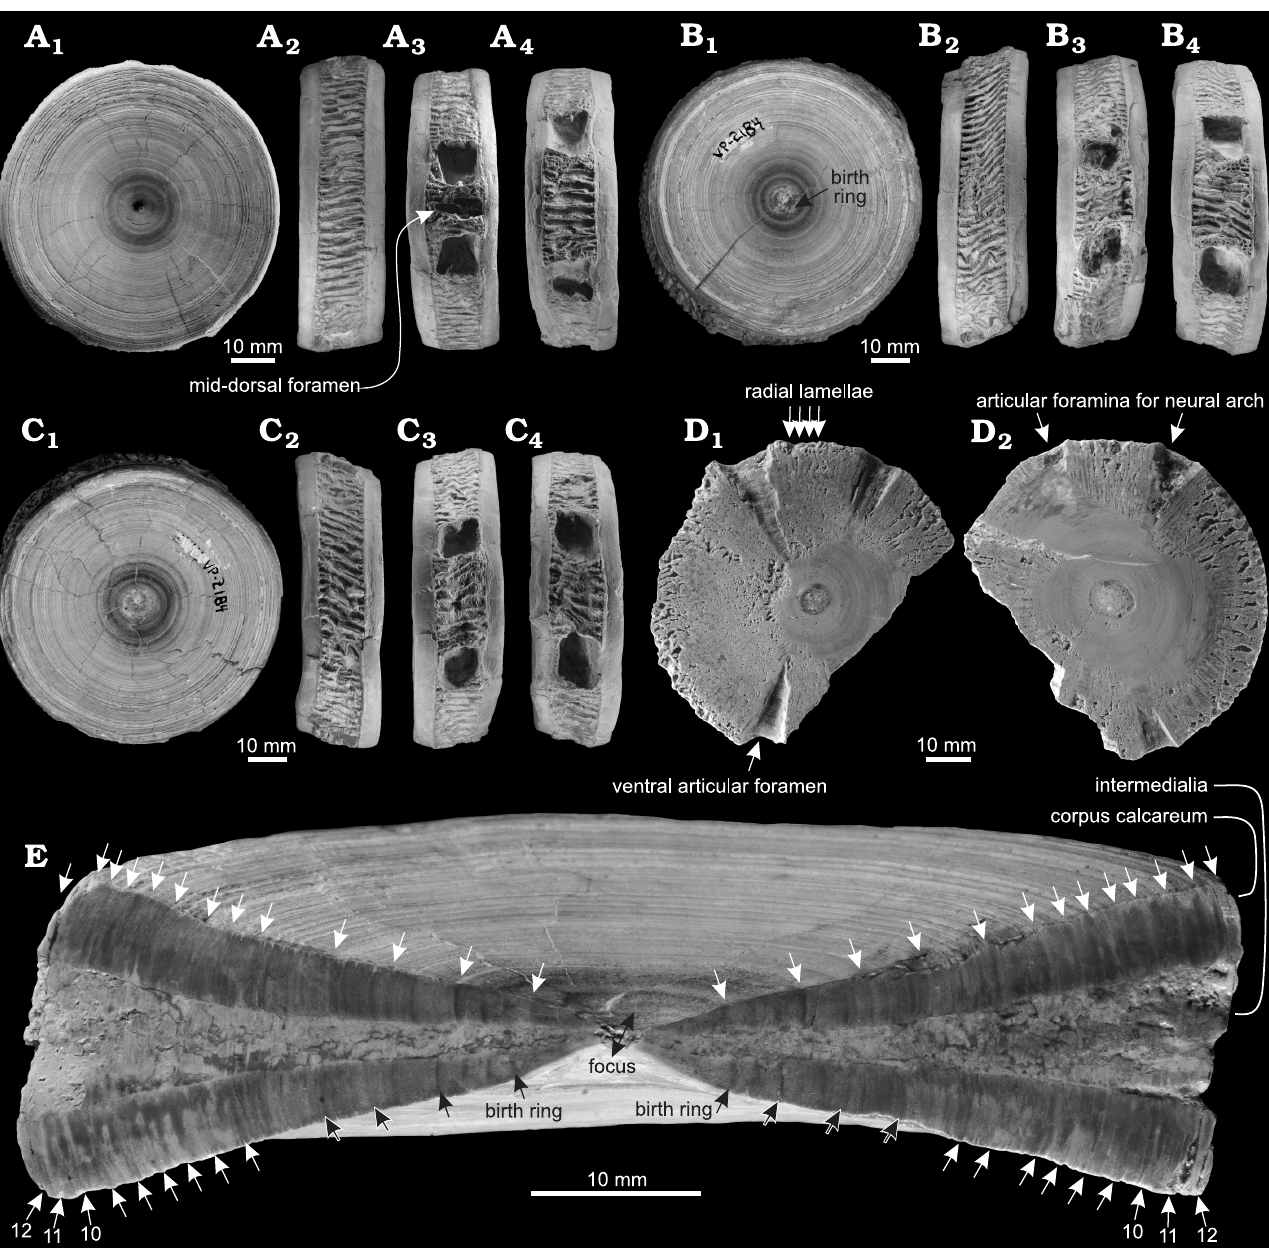
Fig. 8. Five posterior precaudal(?) centra of Cretoxyrhina mantelli Agassiz, 1843, late Coniacian–early Santonian, Smoky Hill Chalk of the Niobrara Chalk, Kansas, USA. A–C . Centra, FHSM VP-2184a ( A ), FHSM VP-2184b ( B ), and FHSM VP-2184c ( C ), in anterior or posterior (A (A –C ), dorsal (A –C ), and ventral (A –C ) views. D . Centrum, FHSM VP-2184d, in transverse section showing radial lamellae and dorsal and ventral 2 2 3 3 4 4 articular foramina; in anterior and posterior (D , D ) views. E . Centrum, FHSM VP-2184e, in hemisected view showing 12 bands 1 2